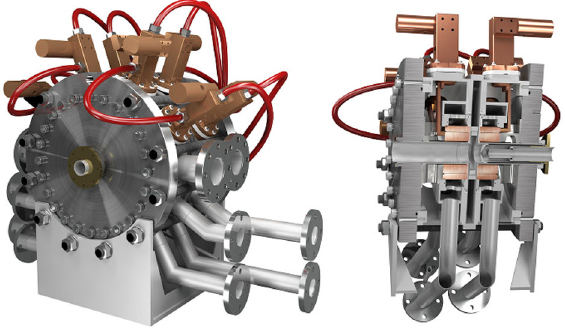
FIG. 29. Three-dimensional view of SEISM prototype.